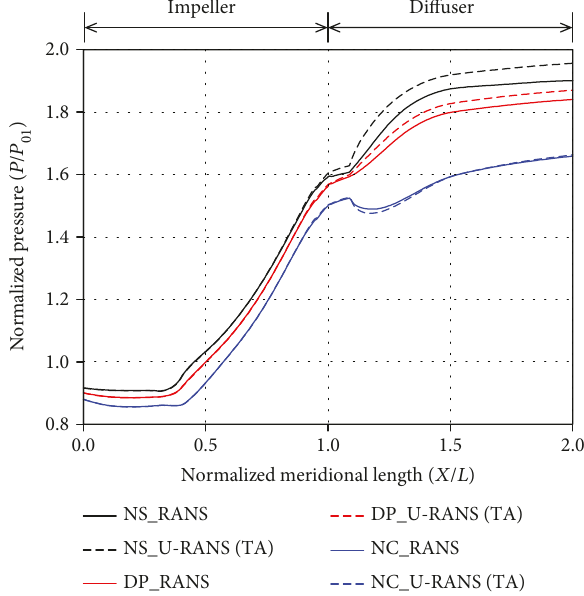
Figure 9: Normalized pressure build-up in the compressor stage.